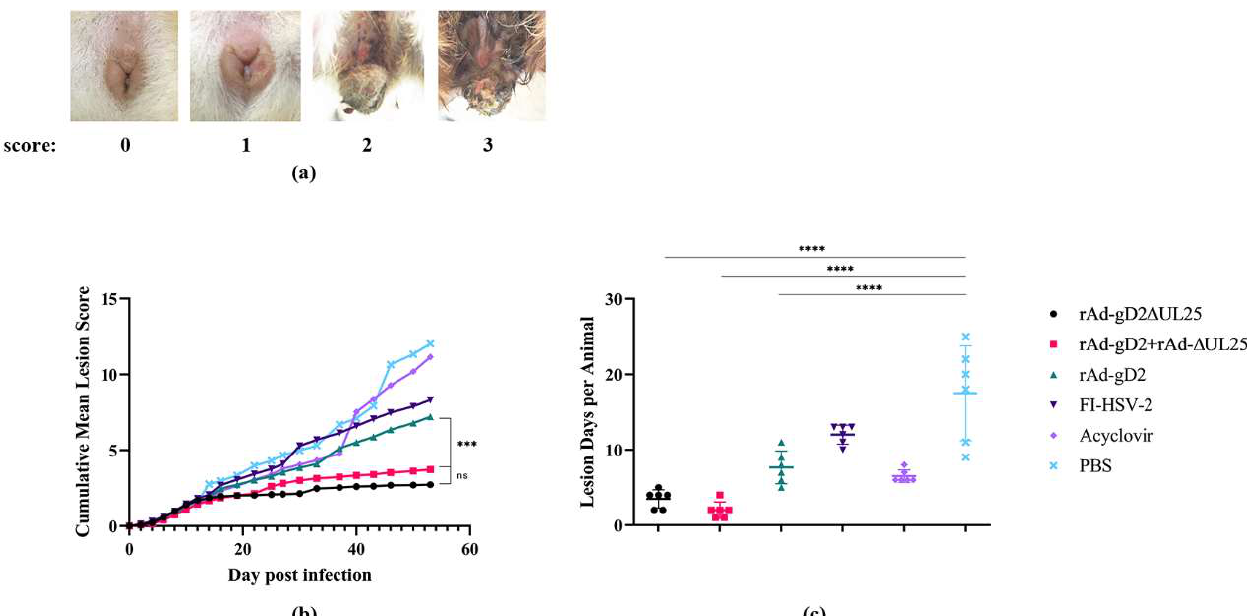
Figure 3. Recurrent disease in guinea pigs. ( a ) Images of different disease scores. 0 = no visible lesion; 1 = redness or swelling; 2 = skin lesions or hair loss; 3 = urine and fecal retention and hind limb paralysis; 4 = death. ( b ) Cumulative mean lesion scores in guinea pigs. All guinea pigs in the vaccinated groups showed reduced scores compared to the mock-immunized group and the group treated with acyclovir. rAd-gD2 ∆ UL25 and rAd-gD2 + rAd- ∆ UL25 both significantly reduce disease lesions than rAd-gD2 group. ( c ) Days of animals with positive lesions are shown. rAd-gD2 ∆ UL25 and rAd-gD2 + rAd- ∆ UL25 both significantly reduce positive lesions than rAd-gD2 group and acyclovir groups. The mean recurrence in rAd-gD2 + rAd- ∆ UL25 group was 2 days and 3.5 days in the rAd-gD2 ∆ UL25 group. **** p < 0.0001; *** p < 0.001; ns, not statistically significant.